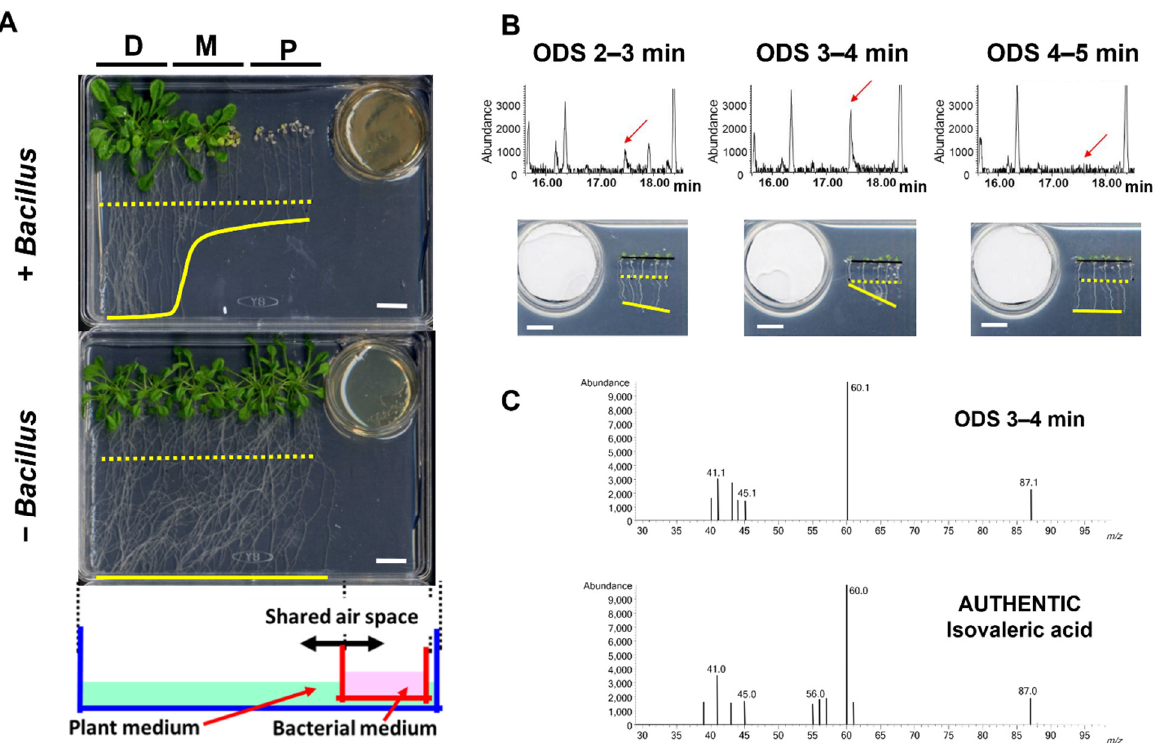
Figure 1. Identification of isovaleric acid as the VOC that inhibits Arabidopsis seedling growth. ( A ) The growth of Arabidopsis (Col-0) seedlings was substantially affected by volatile compounds released from the Bacillus culture. P, M, and D represent the relative distance between the Arabidopsis seedlings and the Bacillus culture: P; proximal, M; mid, D; distal. Shown at the bottom is a schematic of the bioassay setup. The dotted and solid yellow lines represent the positions of root tips at Day 0 and 14 of the bioassays, respectively. White bars, 1 cm. ( B ) The GC analysis and bioassay results of the representative fractions of Bacillus culture containing growth-inhibiting activity towards Arabidopsis seedlings as obtained from an ODS column chromatography. Red arrows: peaks corresponding to plant growth inhibiting activity. The dotted and solid yellow lines in the photographs represent the positions of root tips at Day 0 and 3 of the bioassays, respectively. White bars, 1 cm. ( C ) The